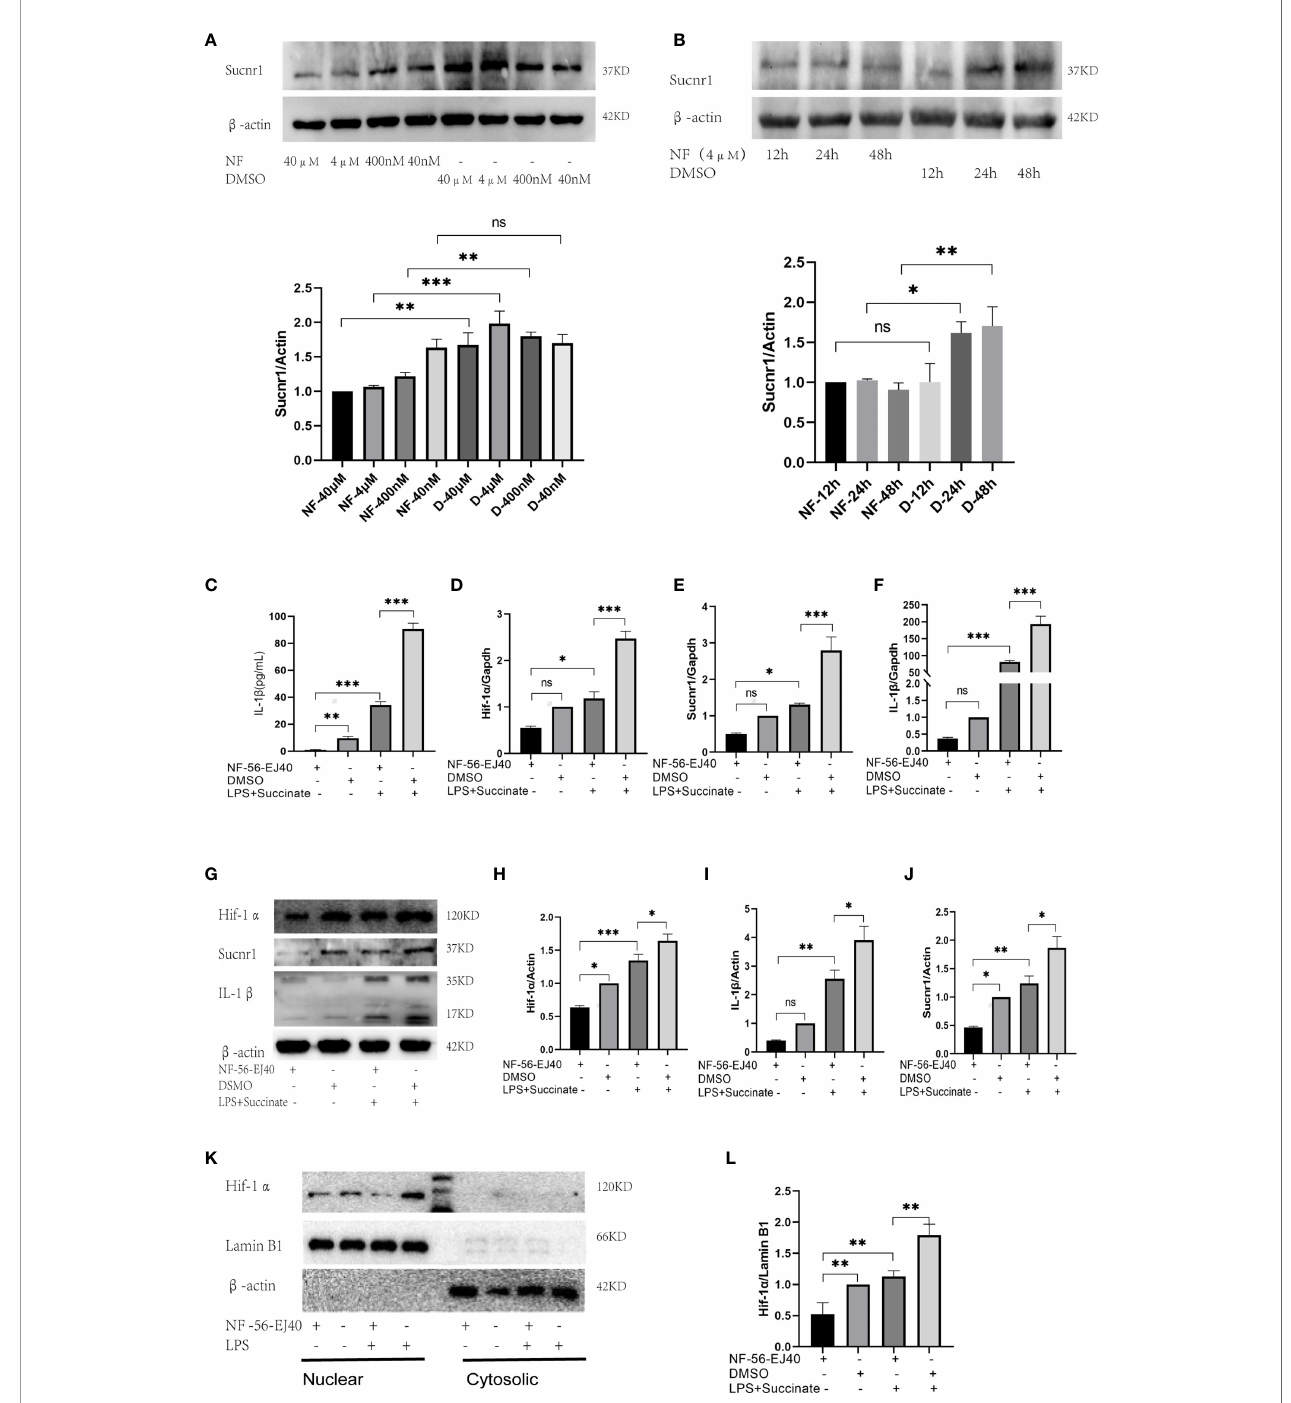
FIGURE 3 | Sucnr1 antagonist inhibits succinate/IL-1 b signal axis in HUVECs. (A, B) HUVECs were used as test cells to determine the optimum time and concentration of NF-56-EJ40 by Western blot. HUVECs were divided into four groups and given intervention according to design: NF-56-EJ40 group, DMSO group, NF-56-EJ40 and LPS+succinate group, DMSO and LPS+succinate group. (C) IL-1 b of supernatant medium was detected via ELISA. (D – F) mRNAs of Sucnr1, Hif- 1 a , and IL-1 b were tested using rt-PCR, in which Gapdh was the reference mRNA. (G – J) Expression levels of Sucnr1, Hif-1 a , and IL-1 b were displayed via Western blots. (K, L) Expression levels of Hif-1 a in nucleus were detected using Western blots. Western blot data present mean ± SEM from three independent experiments at least. ELISA results represent mean ± SD from three different experiments at least. * P < 0.05; ** P < 0.01; *** P < 0.001; ns means no statistical